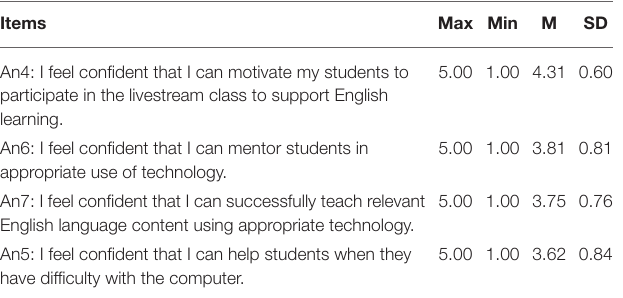
TABLE 7 | Descriptive analysis of EFL teachers’ instructional self-efficacy scores. Items Max Min M SD An2: I feel confident that I can motivate students who show low interest in livestream English